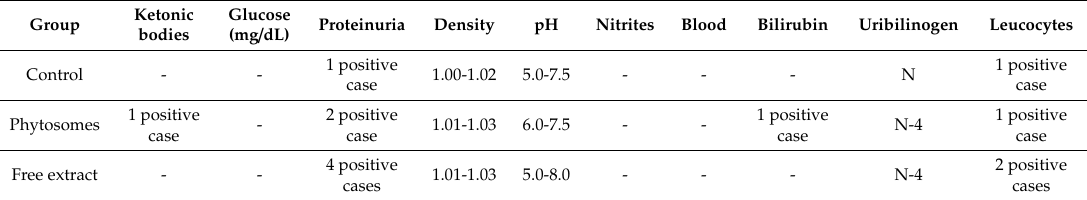
Table 5. Urine analysis.